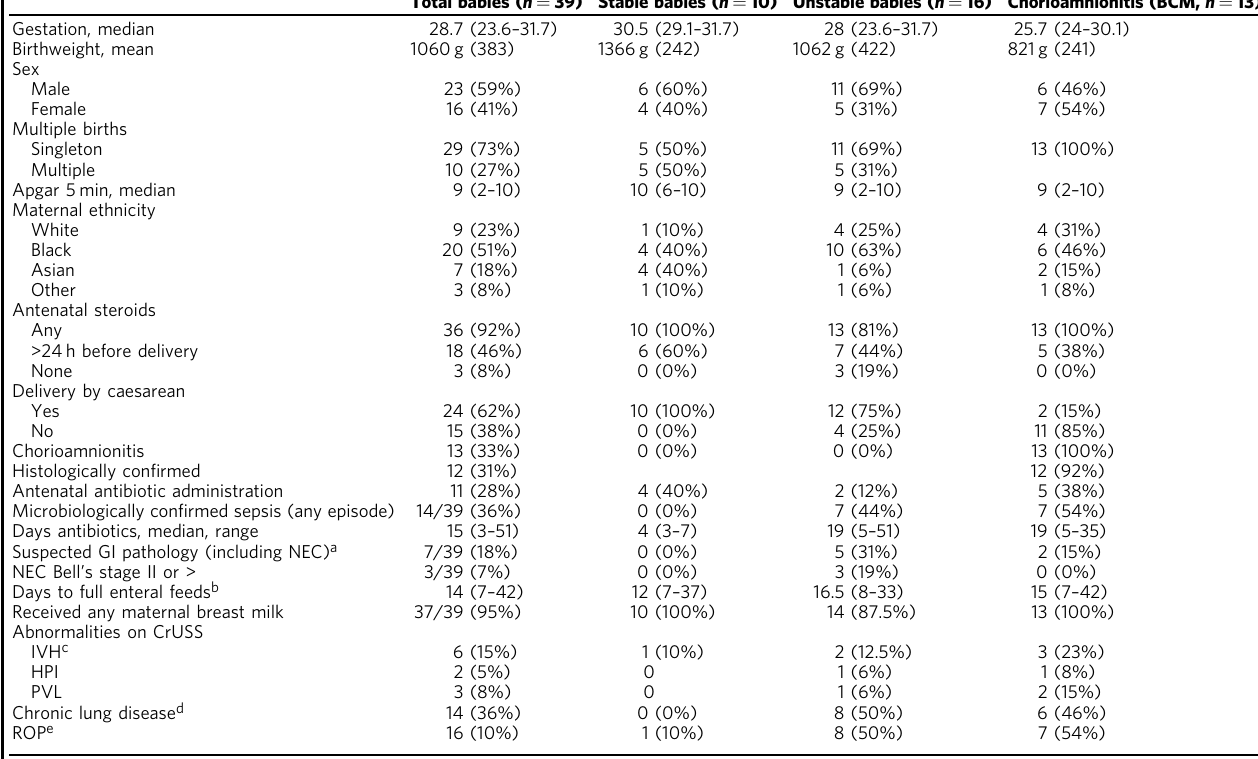
Table 1 Participant demographic and clinical